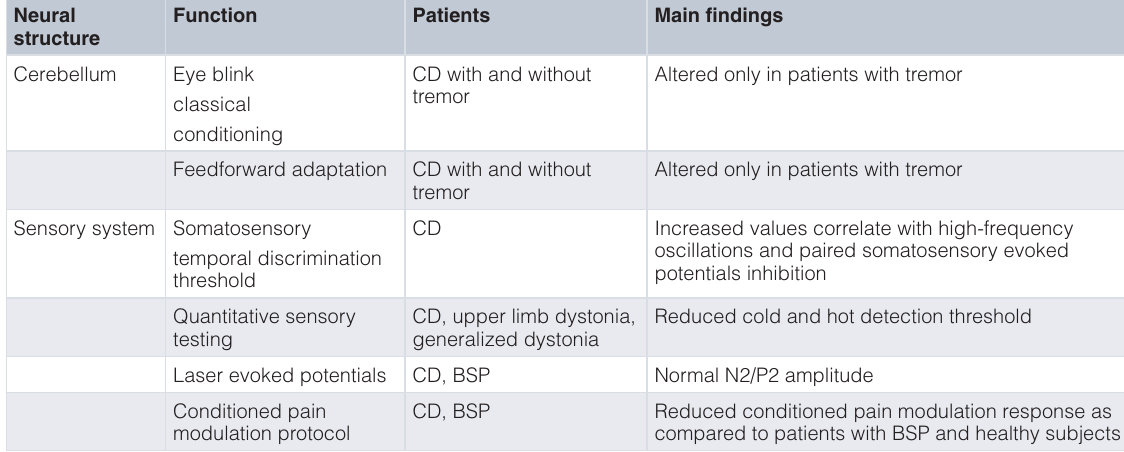
Table 1. Recent neurophysiological abnormalities in focal dystonias. Neural